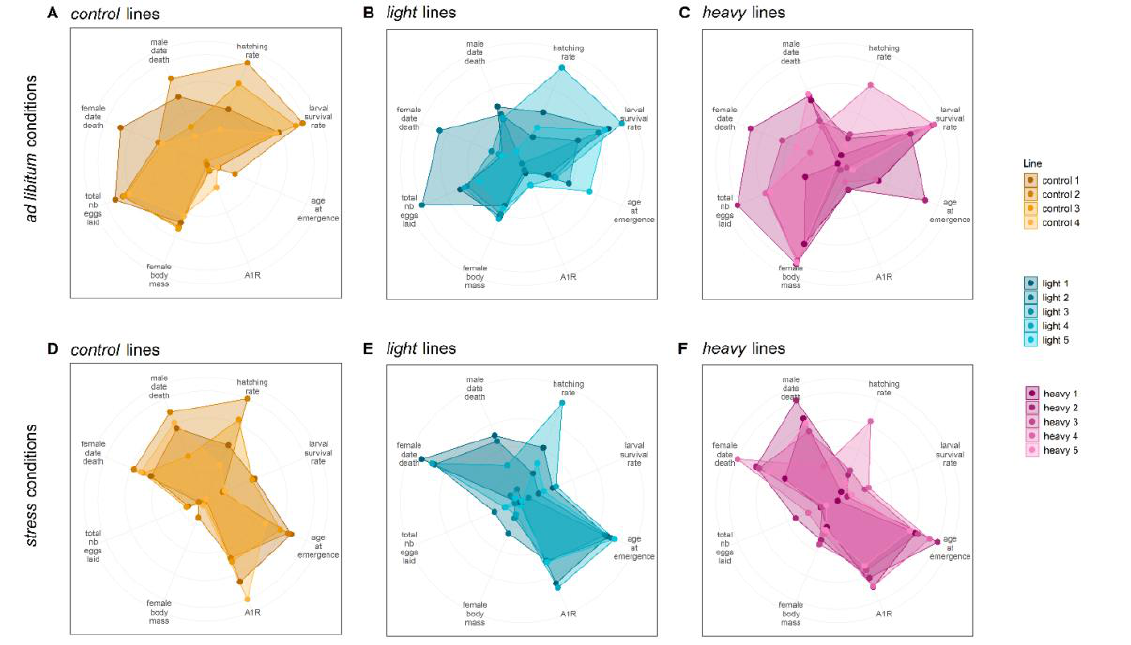
Figure 6: Multi-trait phenotypes of experimental lines of the female body mass selection scheme. (A-C) Radar plots of G9 control, light and heavy lines phenotyped under ad libitum conditions for eight traits. The lines display a strong phenotypic response on the selected trait (female body mass), while the rest of their phenotype remains similar. A1R stands for age at first reproduction. (D-F) Radar plots of G9 control, light and heavy lines phenotyped under stressful conditions for eight traits. The lines display a similar phenotypic response, which is strongly dissimilar to the phenotypic response obtained under ad libitum conditions. Color code is similar to Figure